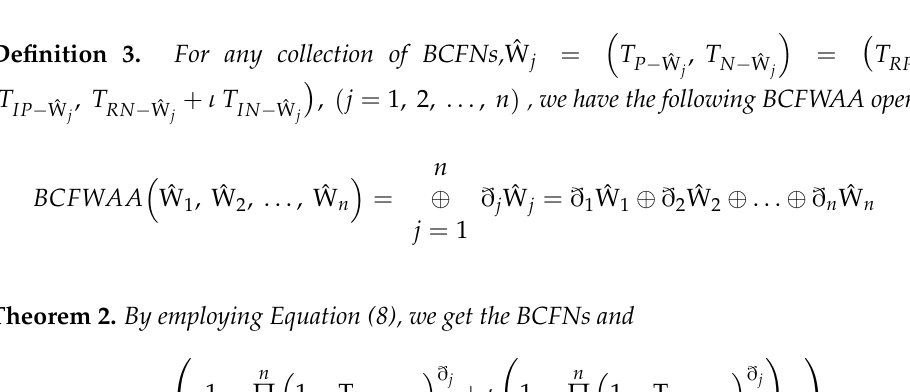
Figure 2 . The geometrical shape of the proposed theory. Figure 2. The geometrical shape of the proposed